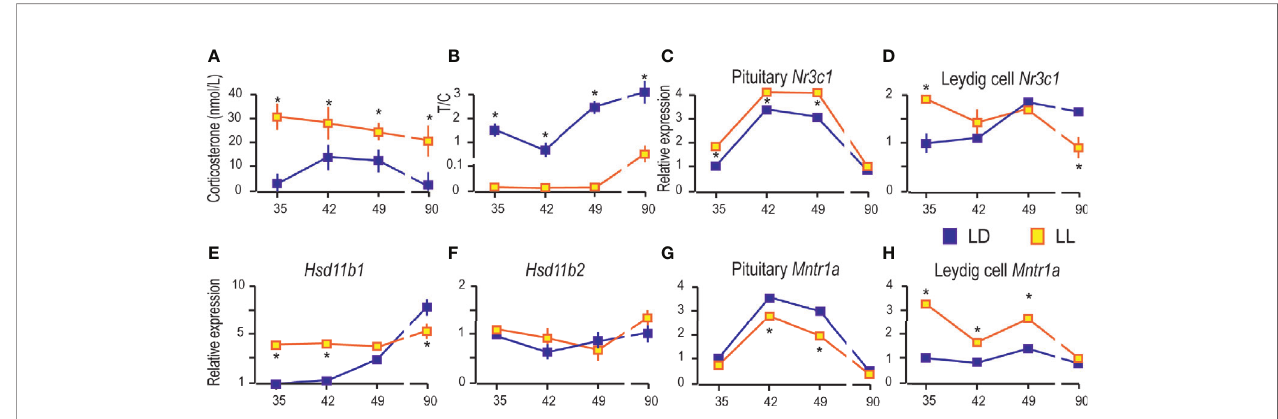
FIGURE 6 | Growing up under constant light increased blood corticosterone and changed the transcriptional pattern of glucocorticoid-signaling elements. Corticosterone levels were monitored in serum from rats that lived in LD or LL regime (A) . The blood testosterone/corticosterone (T/C) ratio is presented during growing up (B) . At a certain age Leydig cells were puri fi ed, RNA isolated, and qRT-PCR performed in order to measure expression of genes involved in corticosterone signaling: pituitary Nr3c1 (C) , Leydig cells ’ Nr3c1 (D) and genes encoded local regulators of glucocorticoid levels (E, F) . Relative mRNA expression of pituitary (G) and Leydig cells Mntr1a (H) . Data points represent group means ± SEM values (n = 5 – 8). *Statistical signi fi cance at level p < 0.05 compared to the corresponding LD